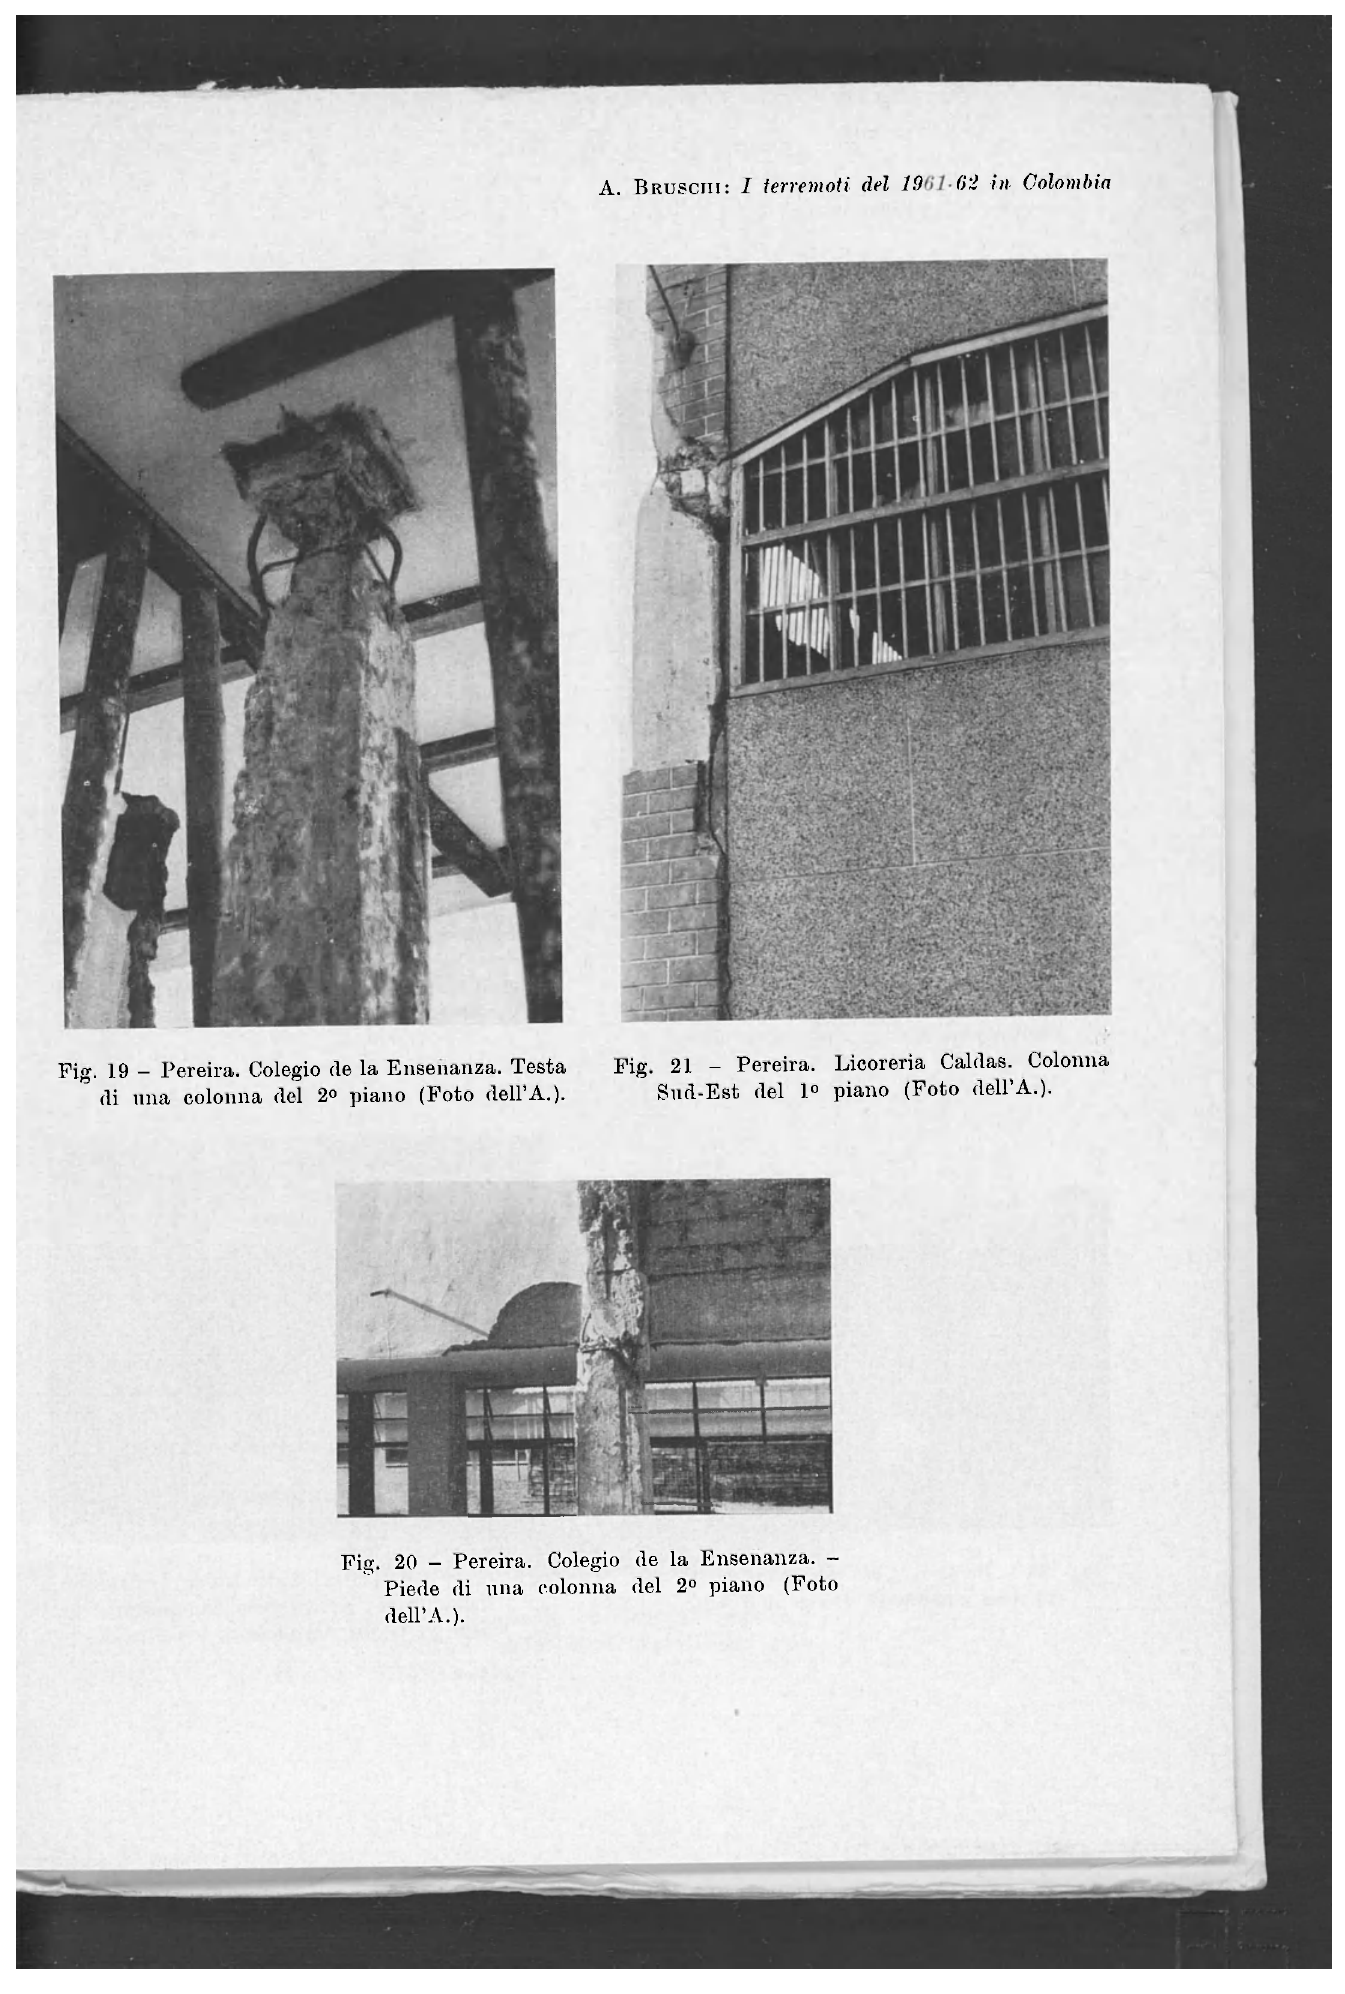
Fig. 20 - Pereira. Colegio de la Ensenanza. - Piede di una colonna del 2° piano (Foto